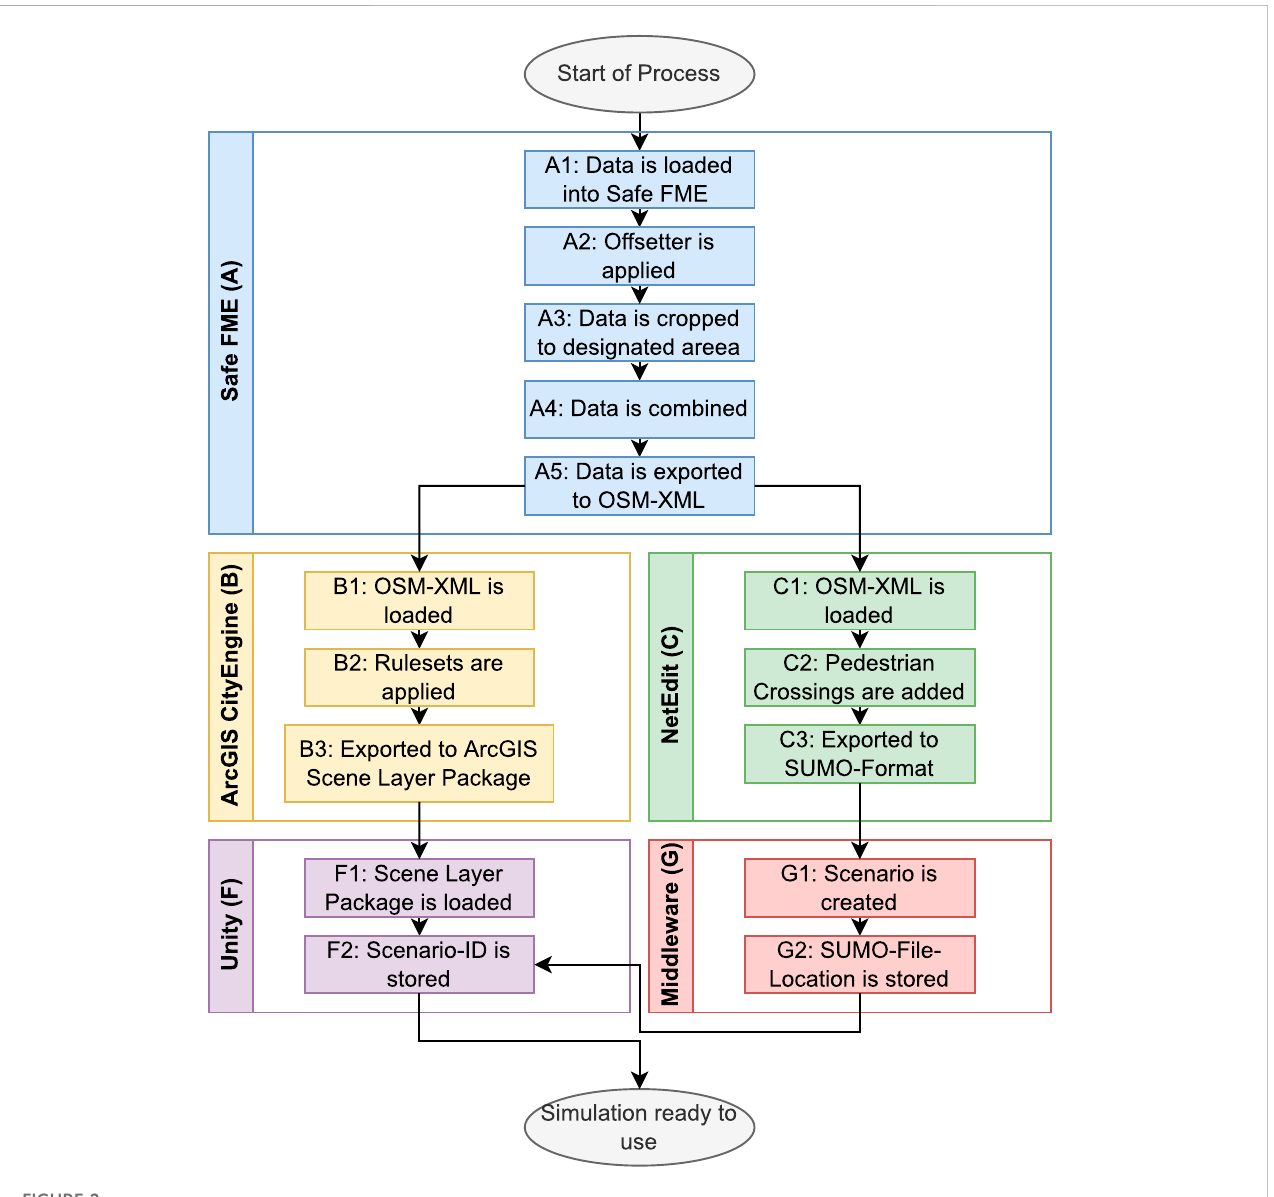
FIGURE 2 Overview of the work fl ow required for the creation of a simulation and visualization. The letters correspond to the letters in Figure 1.